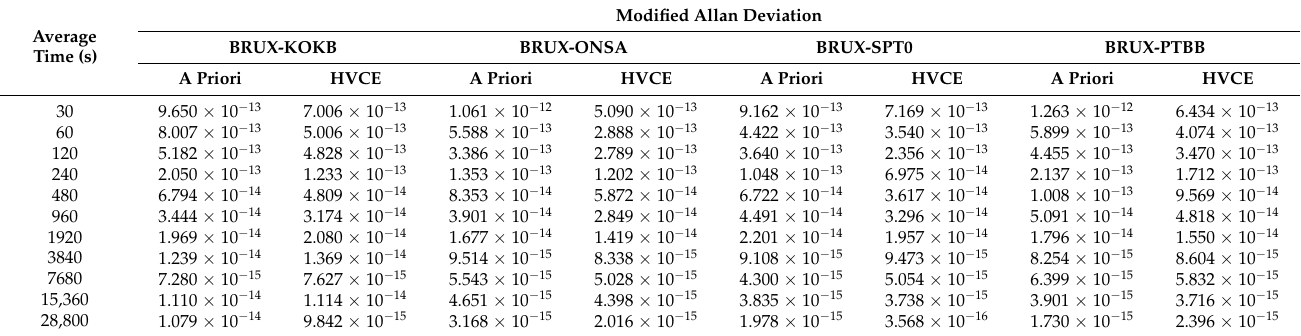
Table 3. MDEV values at several specific average times of four time links with the a priori weighting method and HVCE method on DOY 251,